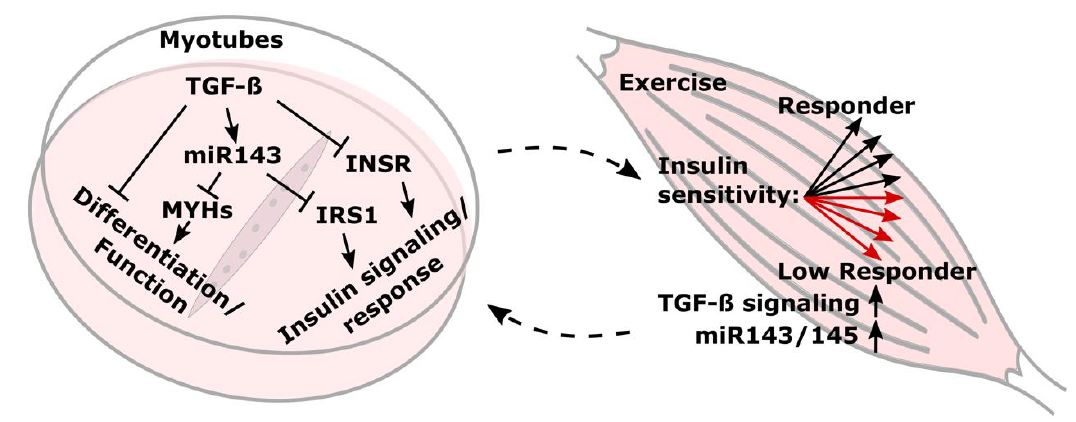
Figure 7. TGF- β -induced miR-143/145 influences differentiation, insulin signaling, and exercise response in human skeletal muscle.